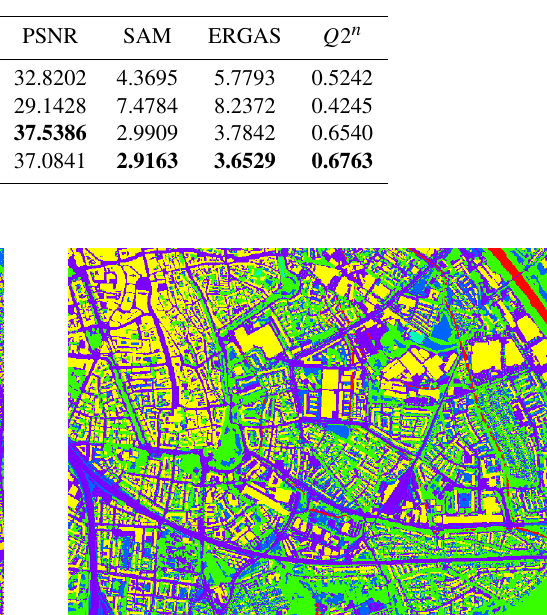
Table 3. Quantitative assessment of super-resolution algorithms. The best results are shown in bold font.